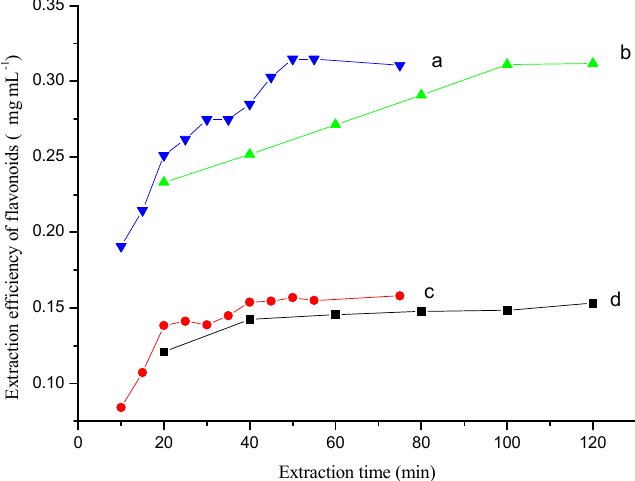
Figure 3. The kinetic behavior of extraction process obtained by the proposed ( a , b ) and traditional extraction method ( c , d ). ( a )—Ultrasonic-assisted osmosis extraction, ( b )—Osmosis extraction, ( c )— Ultrasonic-assisted single solvent extraction, ( d )—Single solvent extraction. Conditions, Folium nelumbinis powder, 0.2 g.